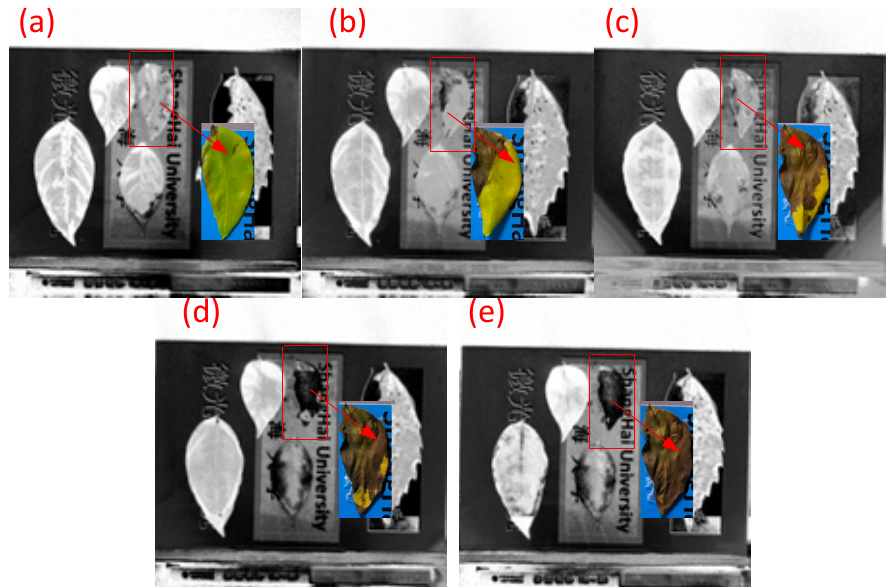
Figure 10. Vegetation index (NDVI) in a time series. Illumination of the NDVI: ( a ) 0.01 lux, ( b ) 0.1 lux, ( c ) 0.5 lux, ( d ) 1.0 lux and ( e ) 5.0 lux.